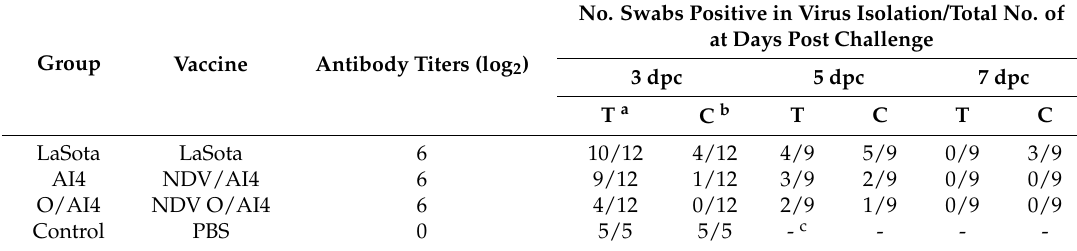
Table 2. Frequency of isolation of challenge virus in different vaccine groups.